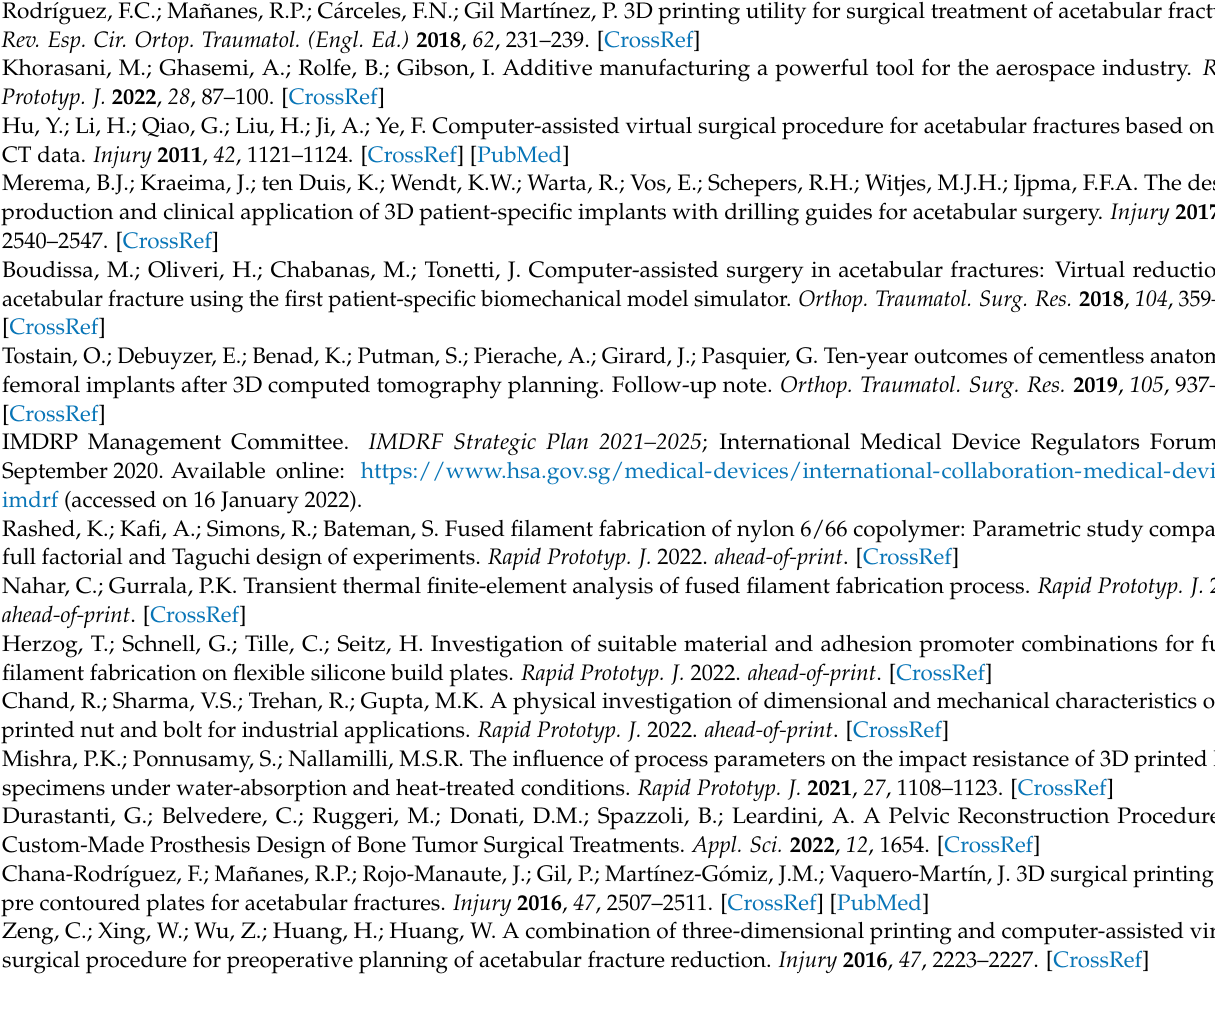
e.g., Pelvis L/R or uninjured, Figure S3. Segmentation correction process (removal of artifacts) using the ‘SCISSORS’ function, Figure S4. Segmentation correction process (removal of artifacts) using the ‘ERASE’ function, Figure S5. Segmentation correction process (removal of artifacts) using the ‘PAINT’ function, Figure S6A–C. Removal of the femur using the ‘ERASE’ function and ‘ISLAND’ function, Figure S7A,B. Creating a 3D model for printing. Select the ‘WRAP SOLIDFY’ function, Figure S8. Select the ‘MARKUP’ module, Figure S9. Select the ‘DYNAMIC MODEL’ module, Figure S10. Select the ‘SURFACE TOOLBOX’ module, Figure S11. Export the